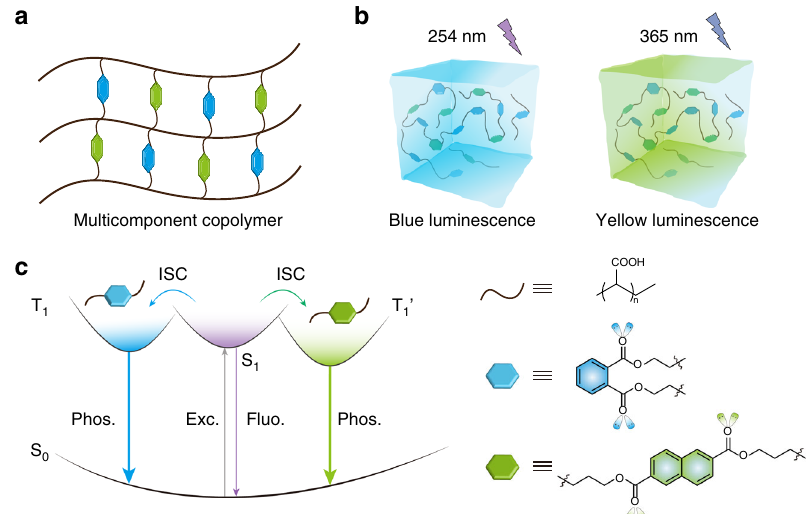
Fig. 1 Schematic illustration of the color-tunable UOP multicomponent copolymer. a Network structure of multicomponent copolymer by radical cross- linking copolymerization. The brown line and blue and yellow hexagons represent PAA chains and various luminophores, respectively. b Excitation- dependent UOP of multi-component copolymer under ambient conditions. The polymer exhibits color-tunable UOP emission upon changes in the excitation wavelength. c Proposed mechanism of color-tunable UOP at room temperature. Multiple triplet excited state T 1 and T 1 ’ generating from different excited singlet states S 1 stem from the various luminophores through ISC. The rigid polymer microenvironment effectively restricts molecular motion for ultralong phosphorescence emission under ambient